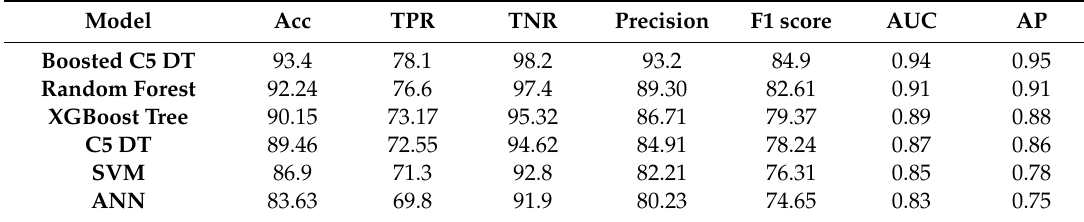
Table 7. Performance evaluation metrics for di ff erent classifiers after feature extraction and selection process.